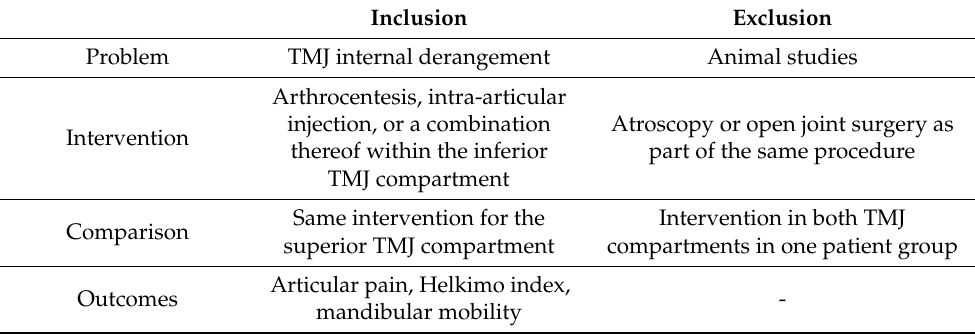
Table 1. Summarized eligibility